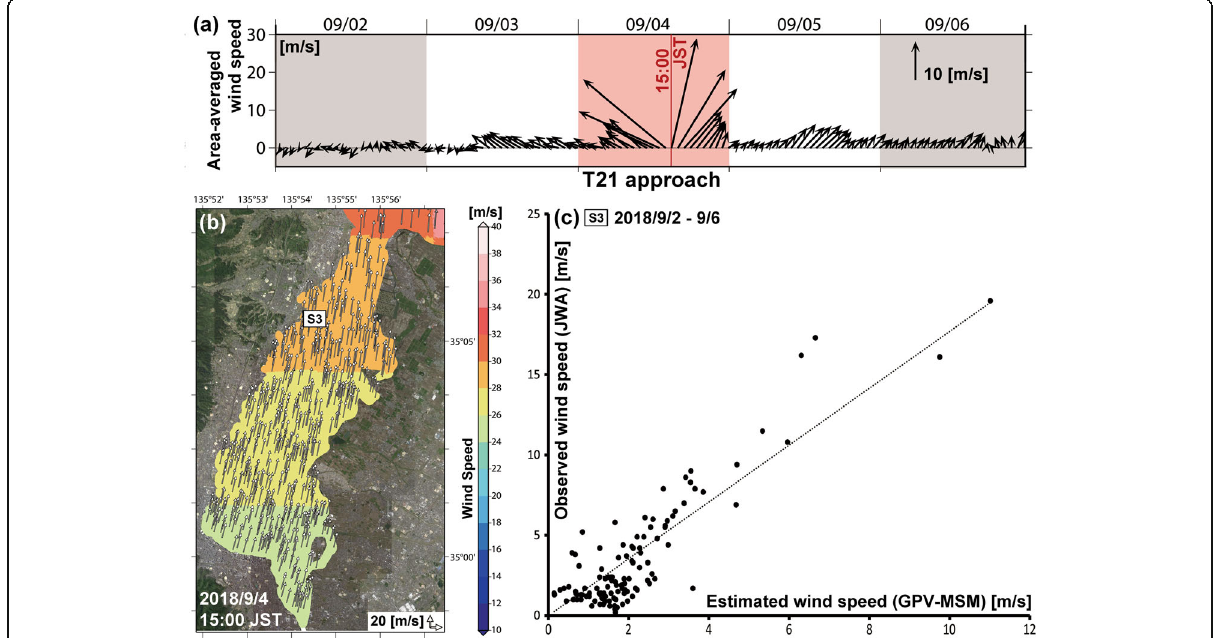
Fig. 8 a Vectors of the area-averaged wind speed derived from the hourly GPV-MSM reanalysis dataset in the southern basin during the period of 2 – 6 September 2018. Red shading indicates the date of the Typhoon 21 approach around Lake Biwa. b Map of the wind vectors and speeds (colors) interpolated using the GPV-MSM reanalysis dataset at 15:00 JST on 4 September. c Scatter plots showing the observed and estimated wind speeds during the period of 2 – 6